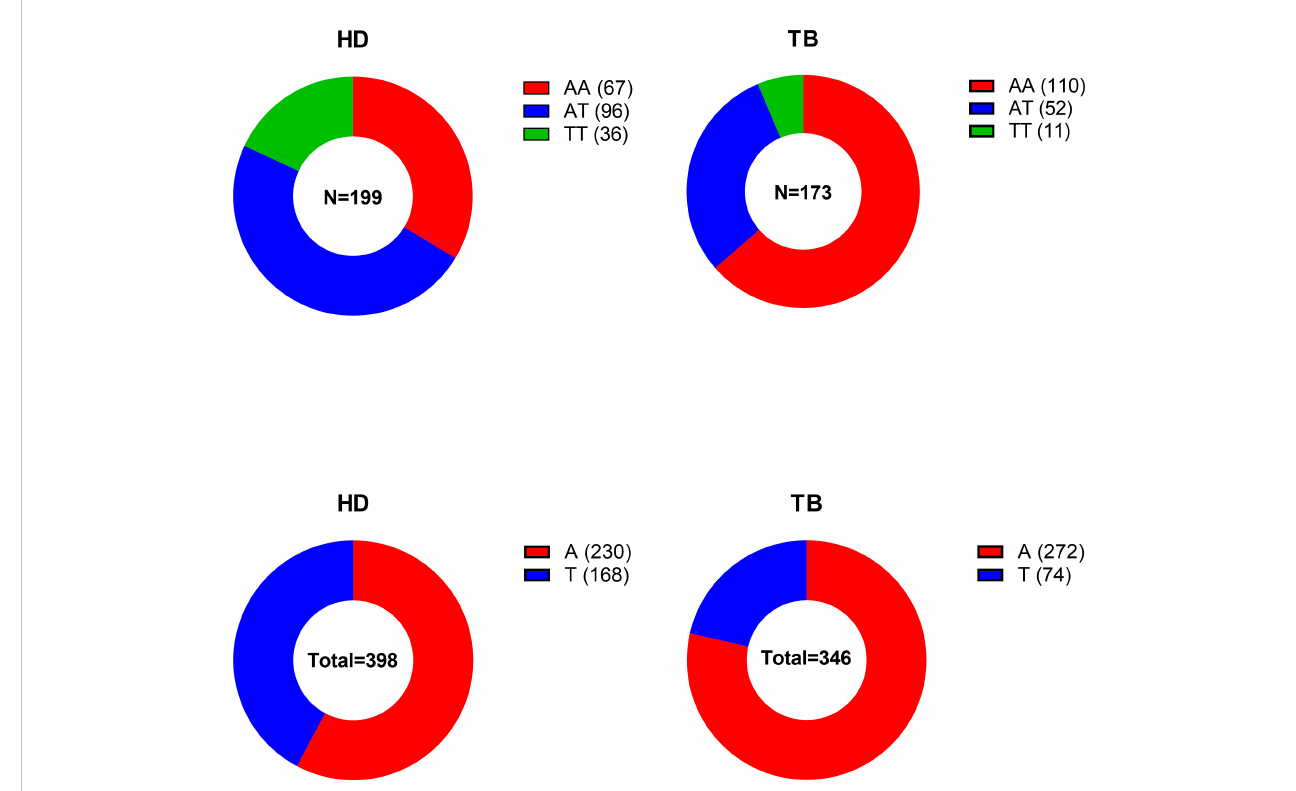
FIGURE 1 Distribution of genotype and allele frequencies of IFN- g gene (+874 A/T) among patients with tuberculosis (TB) and Healthy Donors